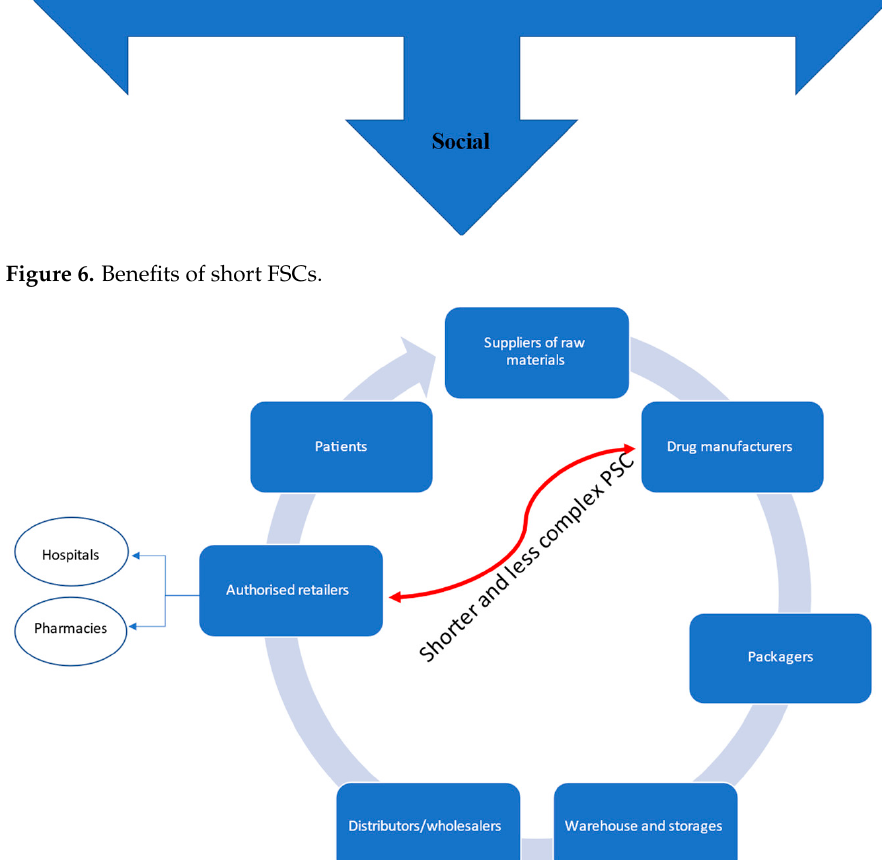
Figure 7. Simplify the networks for PSCs. Source: Balas et al. [146].